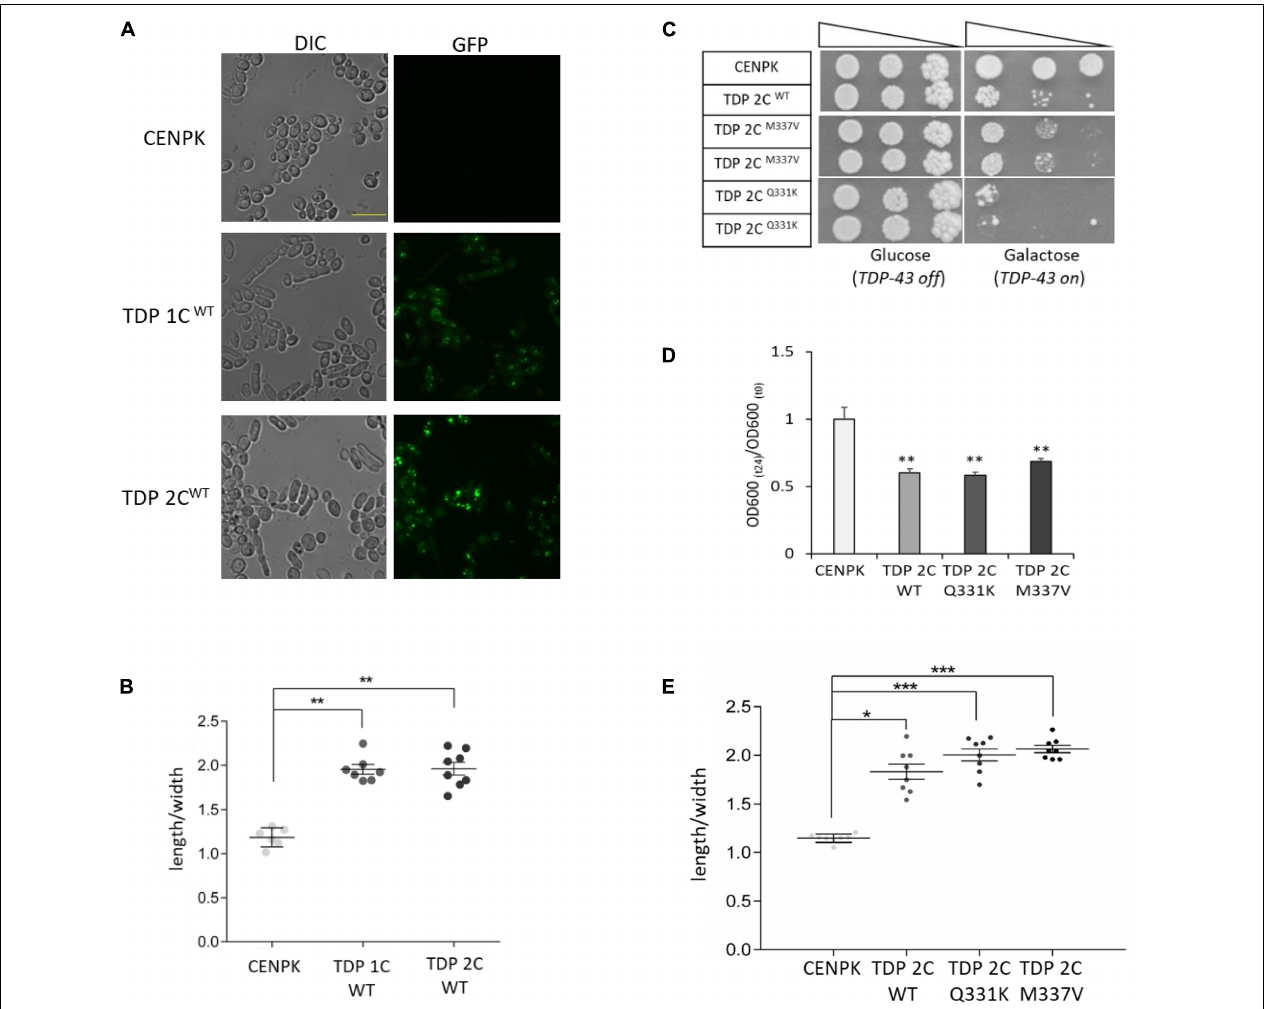
FIGURE 2 | WT and ALS-associated mutants of TDP-43 alter the morphology of yeast cells from rounded to elongated. (A) Yeast cells carrying one (1C) or two (2C) copies of WT TDP-43 transgene, and the CENPK strain, were incubated (48 h) in inducing (galactose-containing) medium, and analyzed for cell morphology by DIC microscopy (left panel), and for TDP-43-GFP expression by epifluorescence (right panel). Shown images are representative of three biological replicates for each strain. Scale bar, 10 µ m. (B) Cell morphology defects in the indicated strains were calculated by measuring the ratio between the cell major and minor axes (length/width ratio) from DIC micrographs. n = 6 (CENPK), 7 (TDP 1C), 8 (TDP 2C) (with each replicate representing the mean value from 60 to 80 cells), ** p < 0.01, Kruskal–Wallis test followed by a Dunn’s post hoc test. (C) Viability assay in yeast strains carrying two copies of either WT or ALS-associated M337V or Q331K missense mutants of TDP-43. Yeast cells (OD 600 = 1) of each strain were serially diluted (10-fold) and spotted onto either inducing medium plates (galactose, TDP-43 on), or repressing condition as control (glucose, TDP-43 off), and incubated at 30 ◦ C for 5 days. Data are representative of three experiments yielding comparable results. (D) The growth rate of the above strains (M337V and Q331K TDP 2C) was measured as described in the legend to Figure 1B . n = 9 for each strain, ** p < 0.01, Kruskal–Wallis test followed by a Dunn’s post hoc test. (E) Yeast shape alteration by the expression (two genomic copies, 2C) of either M337V or Q331K TDP-43 mutants was determined by quantitative morphometric evaluation, as described in (B) . n = 8 for each strain, * p < 0.05, *** p < 0.001 Kruskal–Wallis test followed by a Dunn’s post hoc